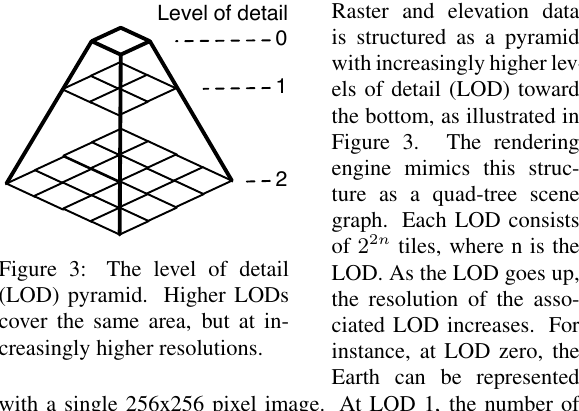
Figure 2: The overall system architecture of Norut’s unmanned systems.